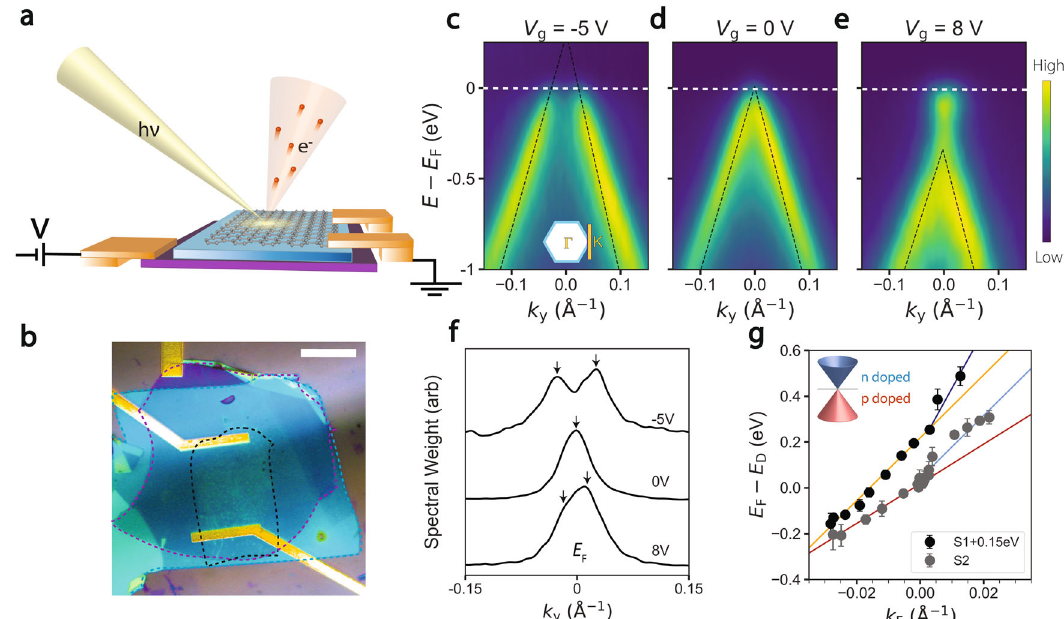
Fig. 1 ARPES in-operando . a , b . Schematic of experimental setup ( a- ) and optical micrograph of the graphene/hBN sample ( b- ). Dashed lines outline regions of graphene (black), hBN (blue), and graphite (purple). Scale bar: 20 μ m ( c.-e .) ARPES spectra for S1 along the K (cid:1) K 0 direction (perpendicular Γ − K ) at ( c- ) p doping (-5V), ( d- ) equilibrium (0V), and ( e- ) n doping (8V). Blue dashed lines indicate quasiparticle peak positions extracted from Lorentzian fi ts. ( f .) doping-dependent MDCs spectra and quasiparticle peak positions (black arrows) at E F , indicated by the white dashed line in (b-d). ( g .) E F − E D as a function of k F , extracted from linear fi ts to the graphene spectra. Data for two different samples are shown (S1 and S2). Error bars indicate 1 σ deviation of best fi t to the linear intersection of the dispersions. Orange (Red) line is a linear fi t to the hole-doped E F data for S1 (S2), Navy (Light blue) line is a fi t to the electron-doped E F data for S1